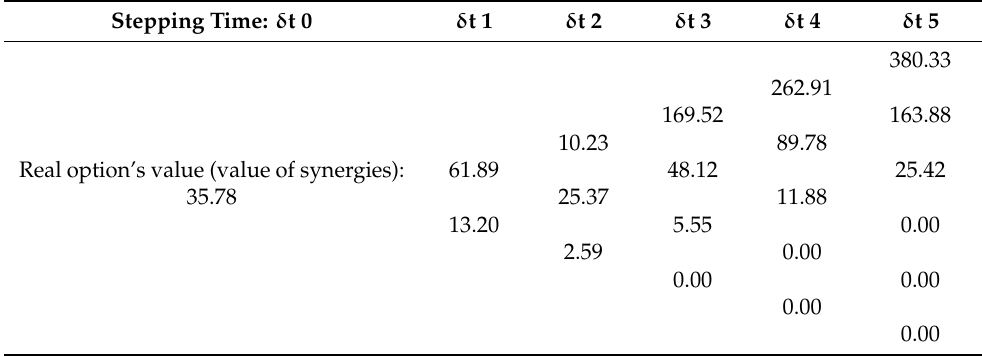
Table 6. Binominal option pricing model. Real options lattice: a value of Samsung Electronics synergies of the acquisition (in $